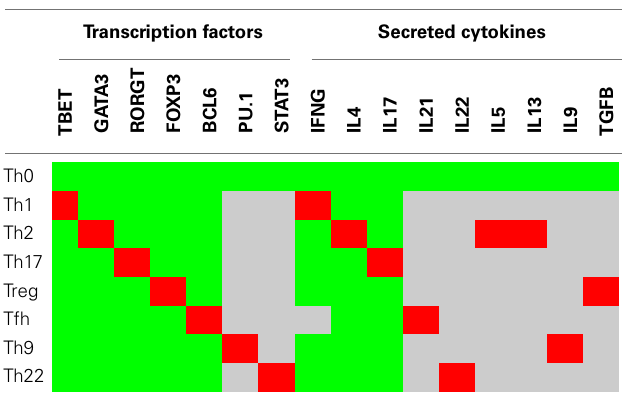
Table 2 | Logical expression patterns for the canonicalTh subtypes